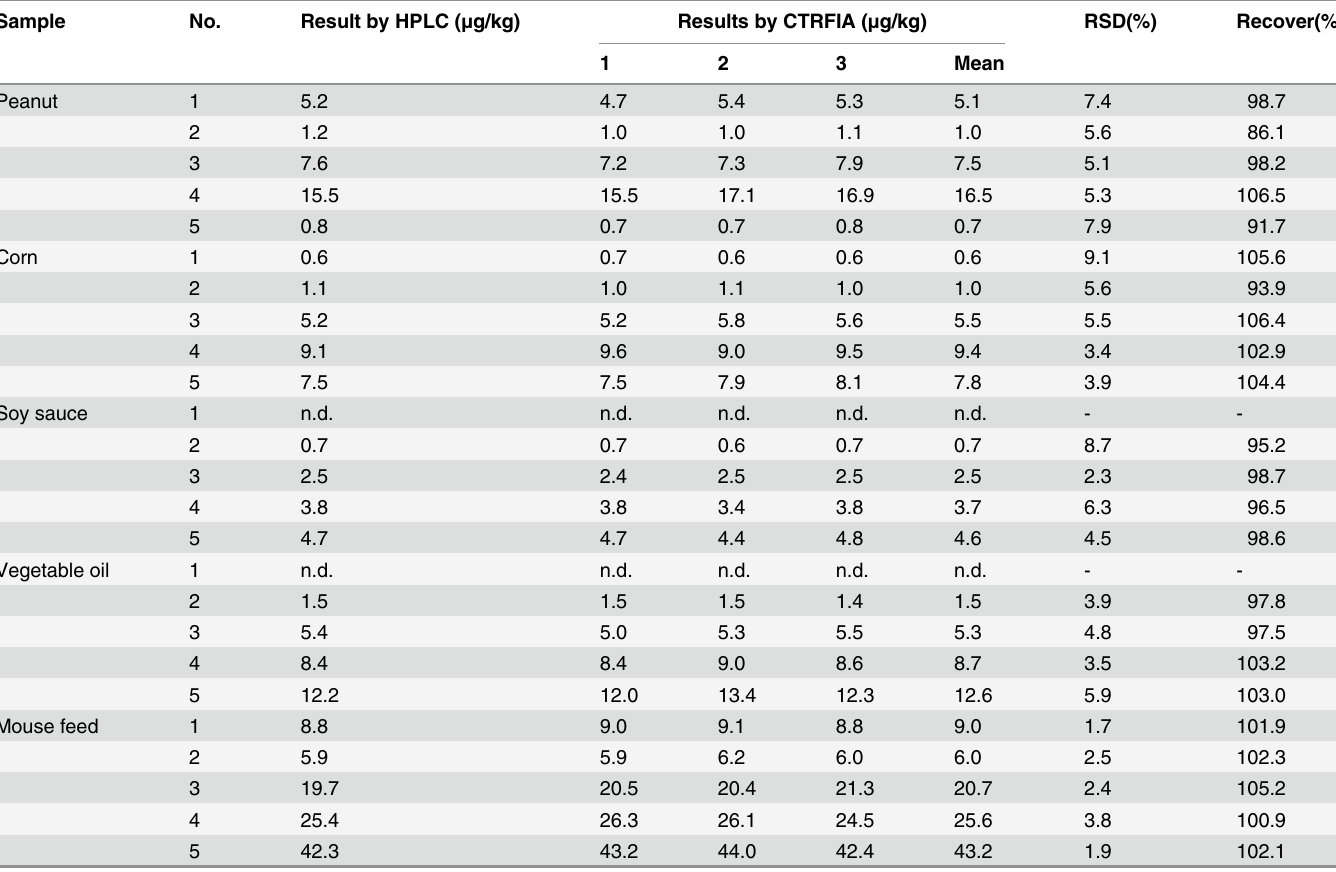
Table 5. Comparison of CTRFIA and HPLC methods for AFB 1 in food and feed samples. Sample No.